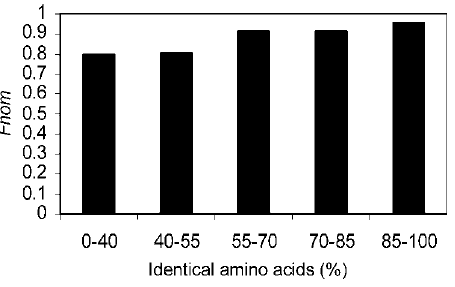
Figure 2. Alignment independence of the FhomEstimator. Homo- loGene homologous protein pairs were divided into five groups according to the identity level of their alignment. The organisms used are human, mouse, fruit fly and C. elegans. The figure reveals that the fraction of homologs estimation (Fhom) is applicable for both closely- related and distantly-related protein